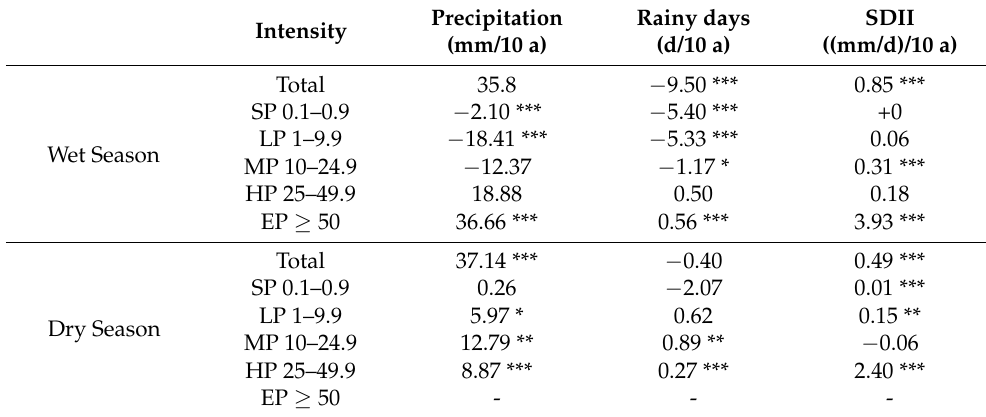
Table 2. Trends of precipitation, rainy days, and SDII in the wet/dry seasons at each intensity level over the Daning River basin during 1979–2017.